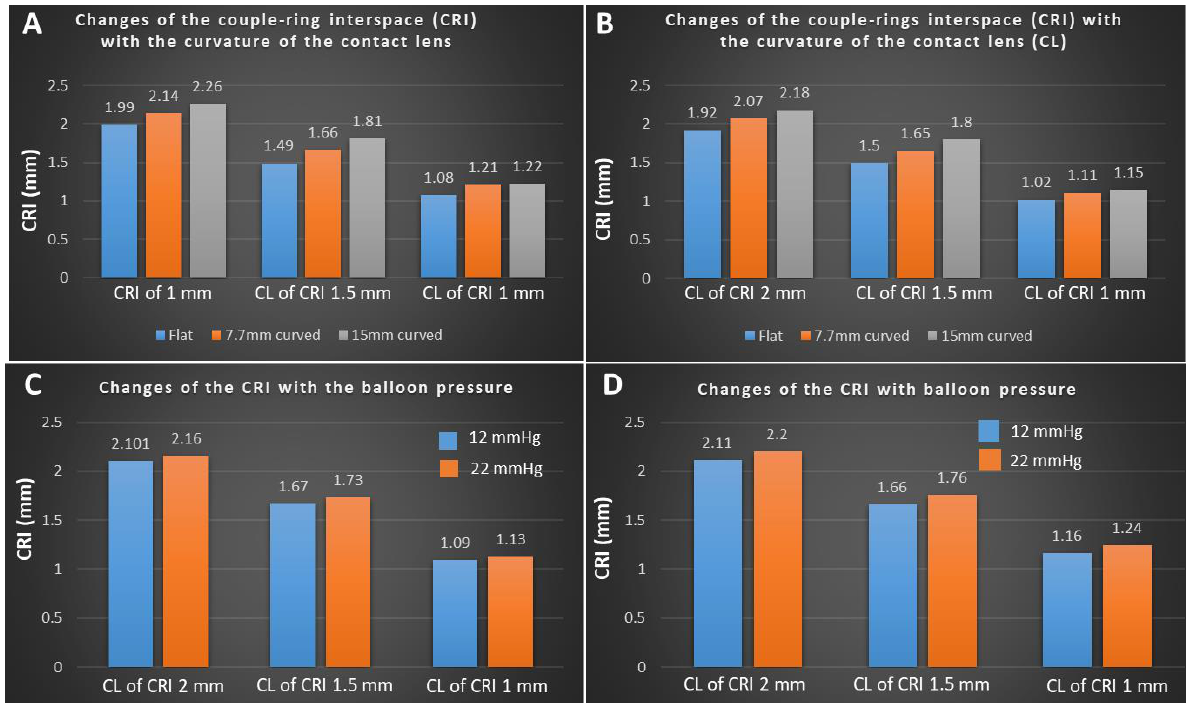
Figure 5. The response of the three processed contact lenses to the changes in their surfaces curvatures. ( A ) the ring-couple interspaces for the three processed contact lenses at different bending conditions; the measurements were carried out on the photos captured from the side where the couple-rings were engraved; ( B ) the ring-couple interspaces for the three processed contact lenses at different bending conditions; the measurements were carried out on the photos captured from the intact sides of the processed contact lenses; ( C ) the ring-couple interspaces for the three processed contact lenses at low and high balloon pressures (12 and 22 mmHg); the measurements were carried out on the photos capture from the side where the couple-rings were engraved; ( D ) the couple-ring interspaces for the three processed contact lenses at low and high balloon pressures (12 and 22 mmHg); the measurements were carried out on the photos captured from the intact sides of the contact lenses.